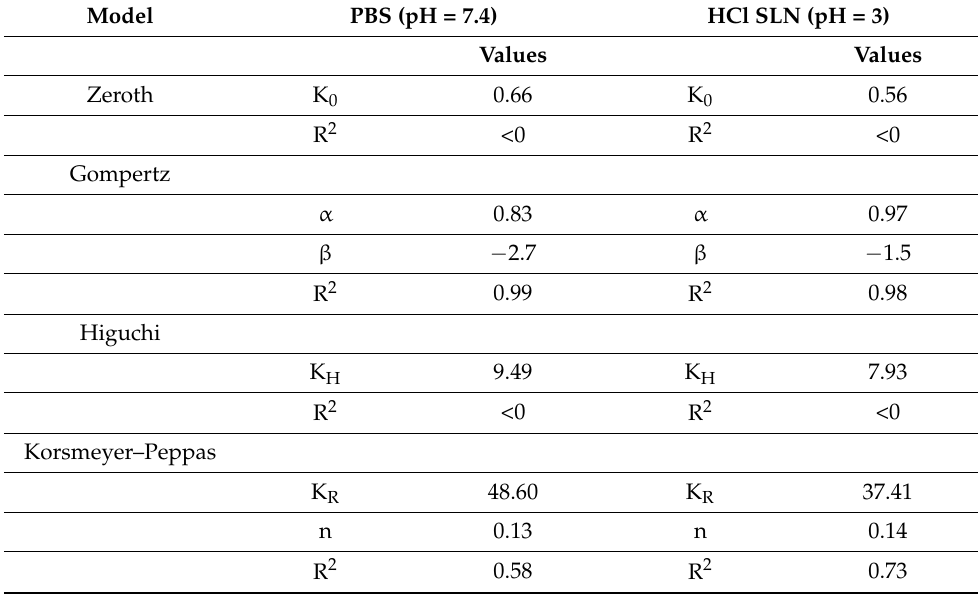
Table 1. Parameters of kinetic models.